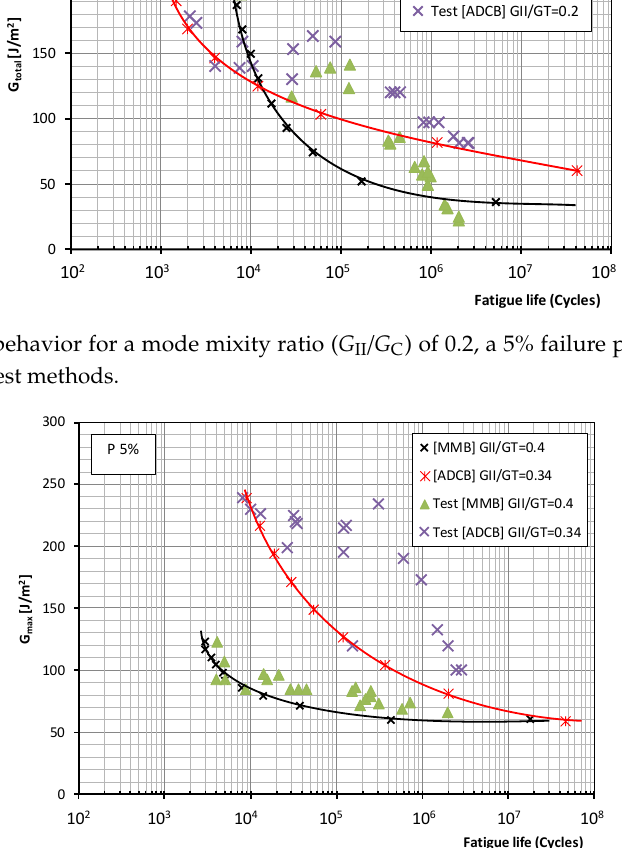
Figure 8. Fatigue behavior for a mode mixity ratio ( G II / G C ) of 0.4 for the MMB test and of 0.34 for the ADCB test and a 5% failure probability.